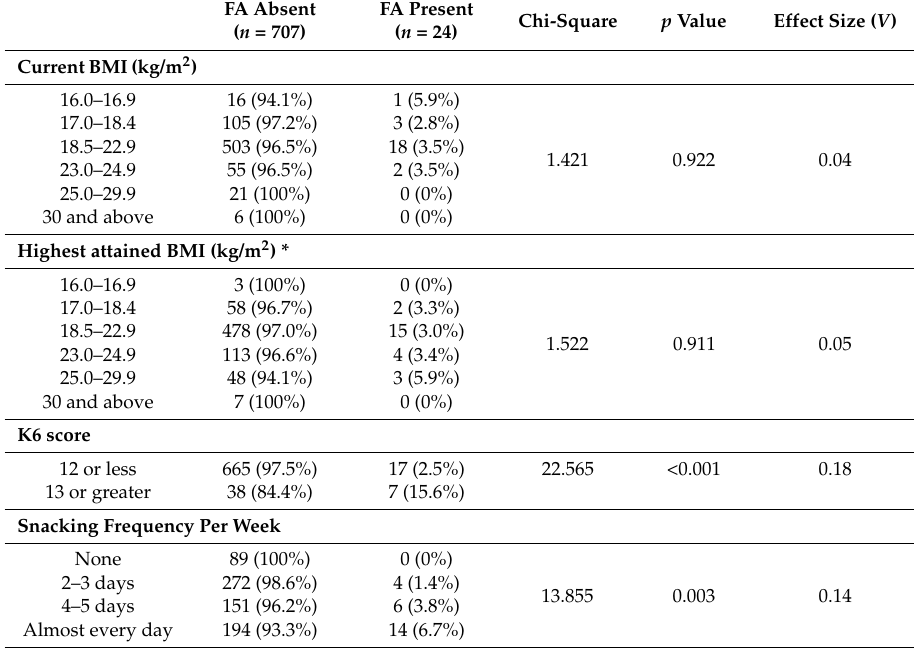
Table 3. Associations of body mass index (BMI), the Kessler Psychological Distress Scale (K6) score, and snacking frequency with the J-YFAS 2.0-diagnosed food addiction (FA) absence/presence. FA Absent ( n = 707)